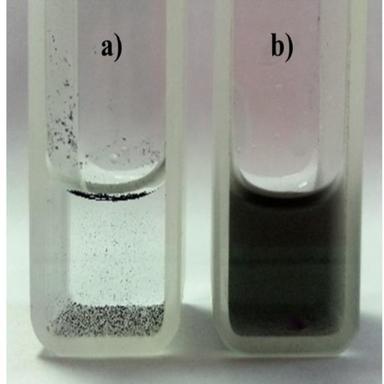
Photographs of a) rGO in acidic solution (1% acetic acid/water) and b) rGO dispersion in acidic solution of CH.